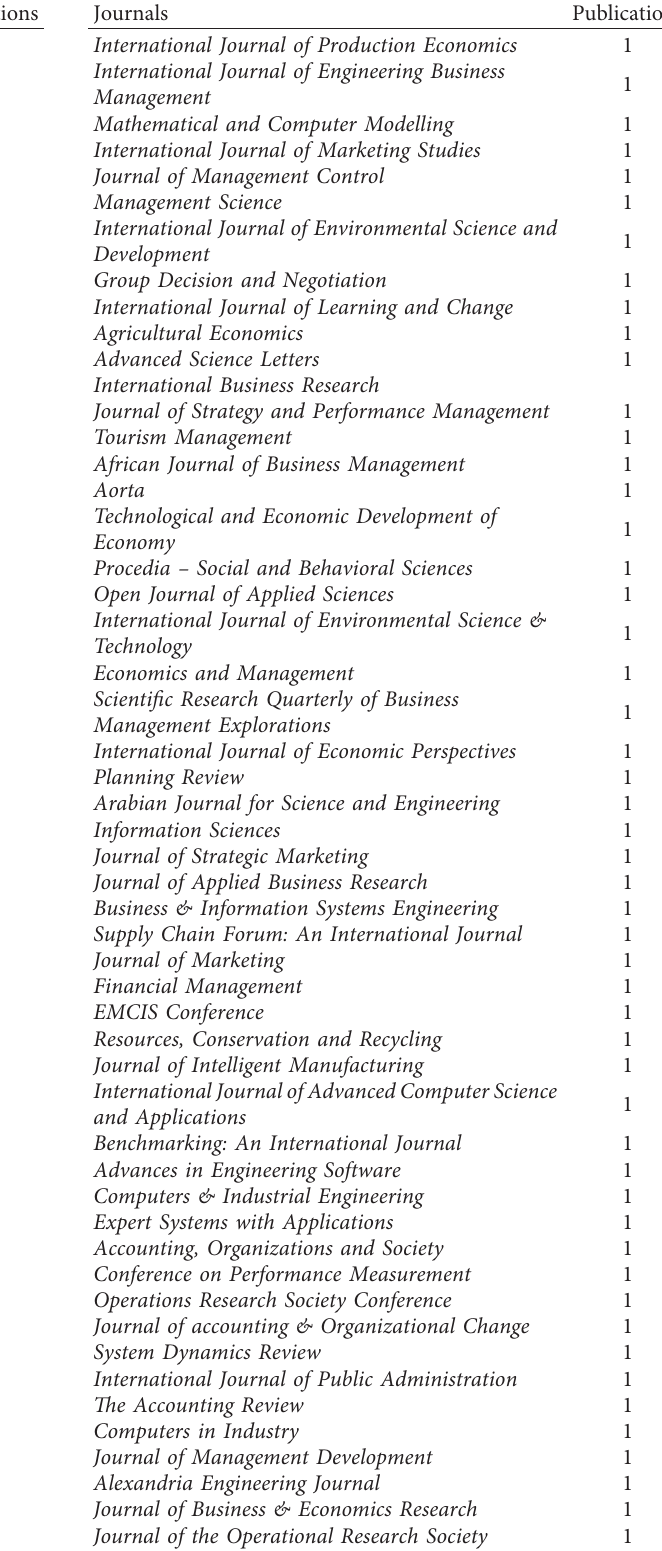
Table 2: Number of publications per journal